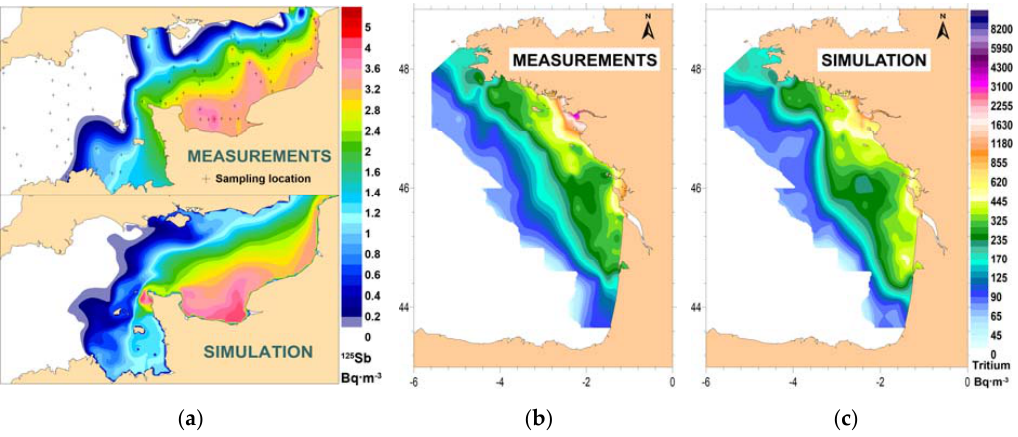
Figure 10. ( a ) Measured and simulated 125 Sb in the English Channel, September 1994, adapted from [24]; measured ( b ) and simulated ( c ) surface 3 H in the Bay of Biscay, spring 2016, adapted from [26]. Computation of the measured and simulated concentrations at each sampling location and time gives statistics of the model representativeness. For example, in the English Channel and the North Sea, application of a residual Lagrangian model gives a mean di ff erence between the 1400 individual values calculated and measured between 1988 and 1994 of 54% [24]. The deviation at a short scale next to an outfall is lower than 70% (Table 2). At the scale of the Biscay Bay with a 3D model the deviation is 21%